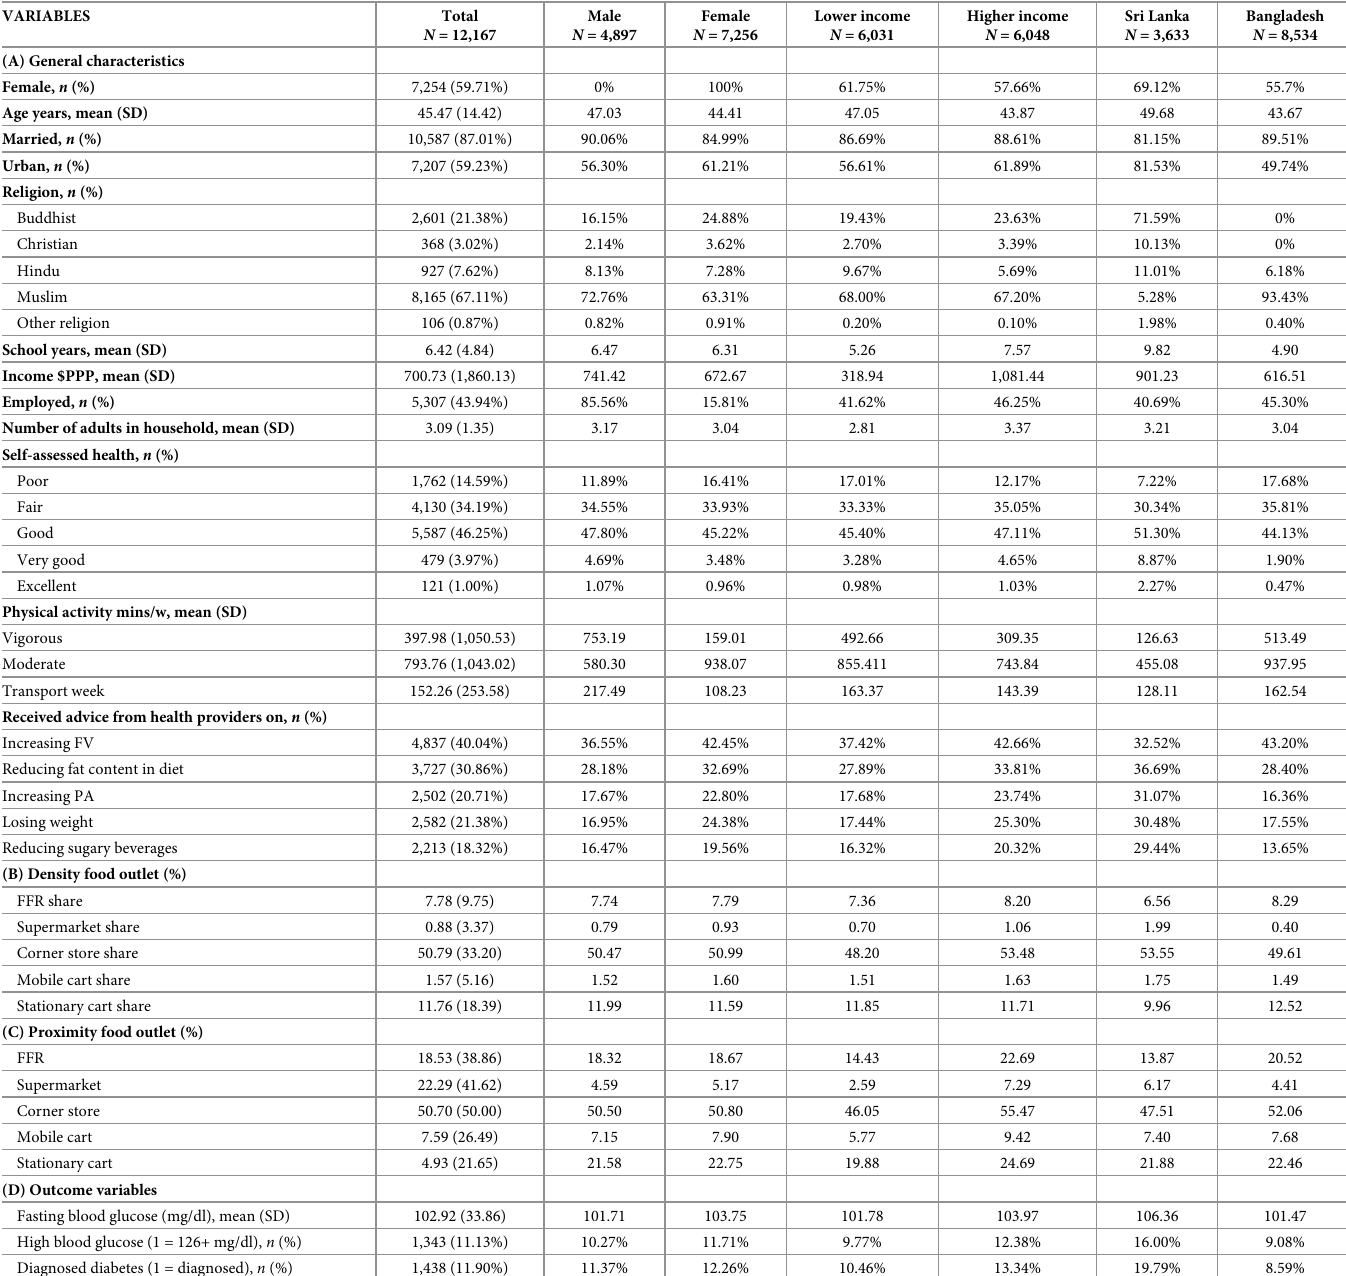
Table 1. Descriptive statistics of sample